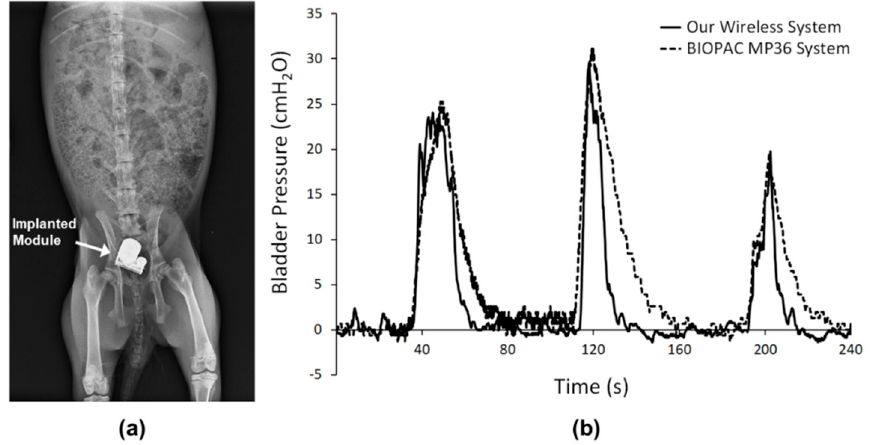
Figure 6. ( a ) X-ray photograph of the biomicrosystem implanted in the bladder cavity of a rabbit. ( b ) Comparison of the inner bladder pressure signals recorded using our wireless system (solid line) and a commercial biological signal acquisition system (dashed line).